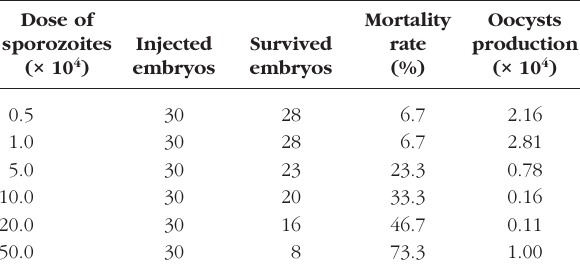
Dose of sporozoites (× 10 4 )